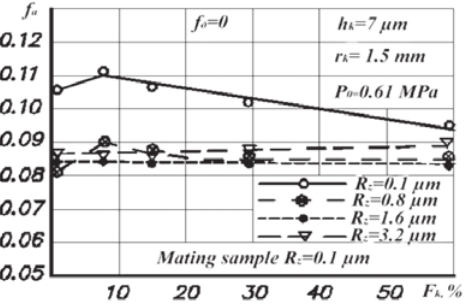
Fig. 7. Dependence of the adhesion component of the friction factor f а on the bottom radius of a micro groove r к